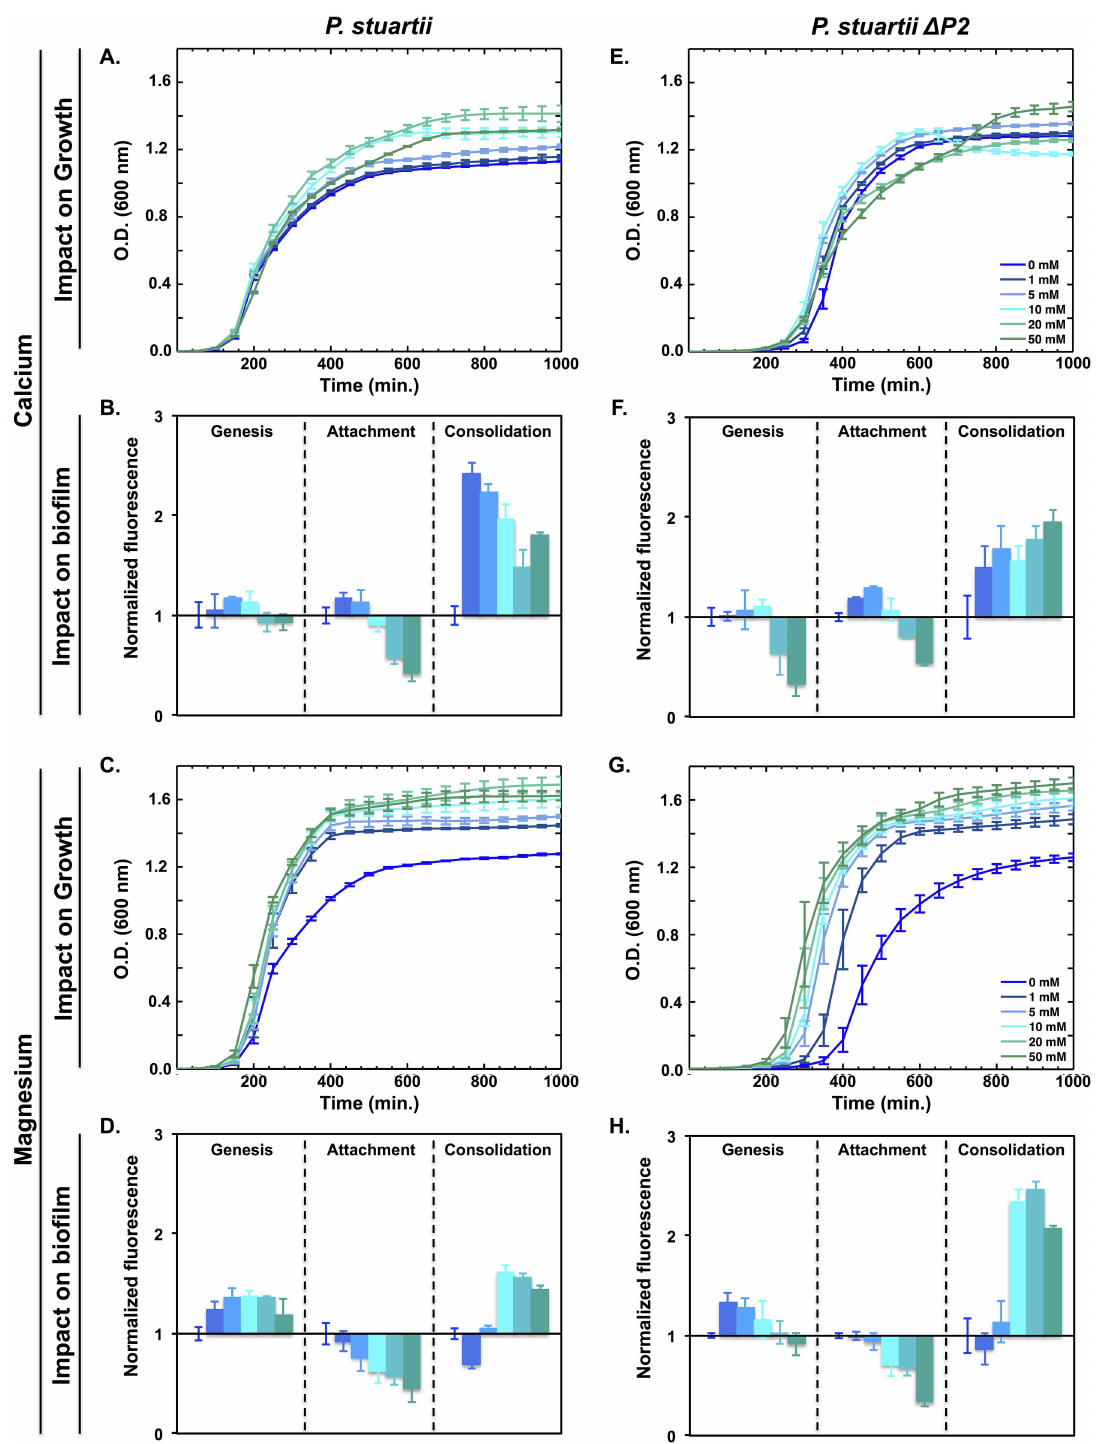
Fig 5. Resistance of P . stuartii and P . stuartii - Δ P2 cells to high concentrations of calcium and magnesium. Effect of calcium (A and E) and magnesium(C and G) on bacterial growth, as judgedfrom the O.D. of cultures at 600 nm. The impact on biofilm genesis,attachment and consolidation was evaluatedby addingcalcium (B and F) or magnesium(D and H) during the lag, stationary and preformed biofilm phases, respectively. Biofilm formation was quantified24 h later, by PrestoBlue staining.Fluorescence values were normalized with respect to the control wells buffered at pH7 and devoidof urea.